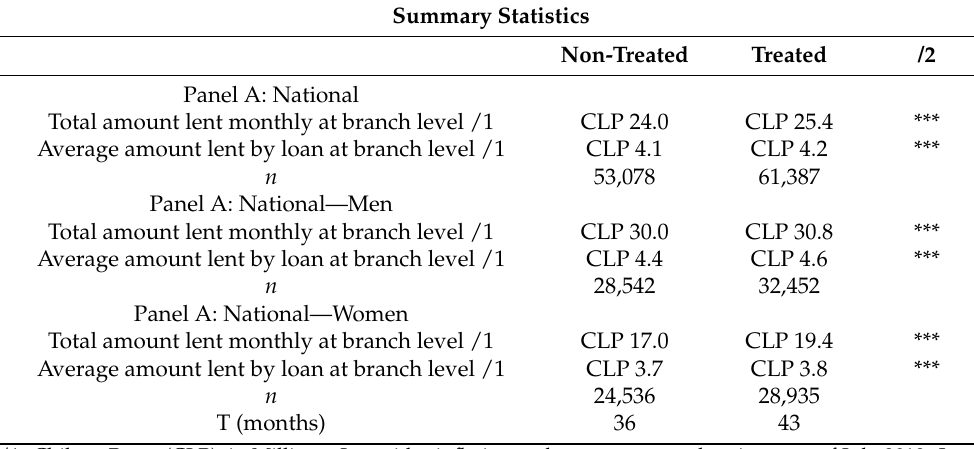
Table 3. BancoEstado Microempresas loans’ summary statistics—National. Summary Statistics